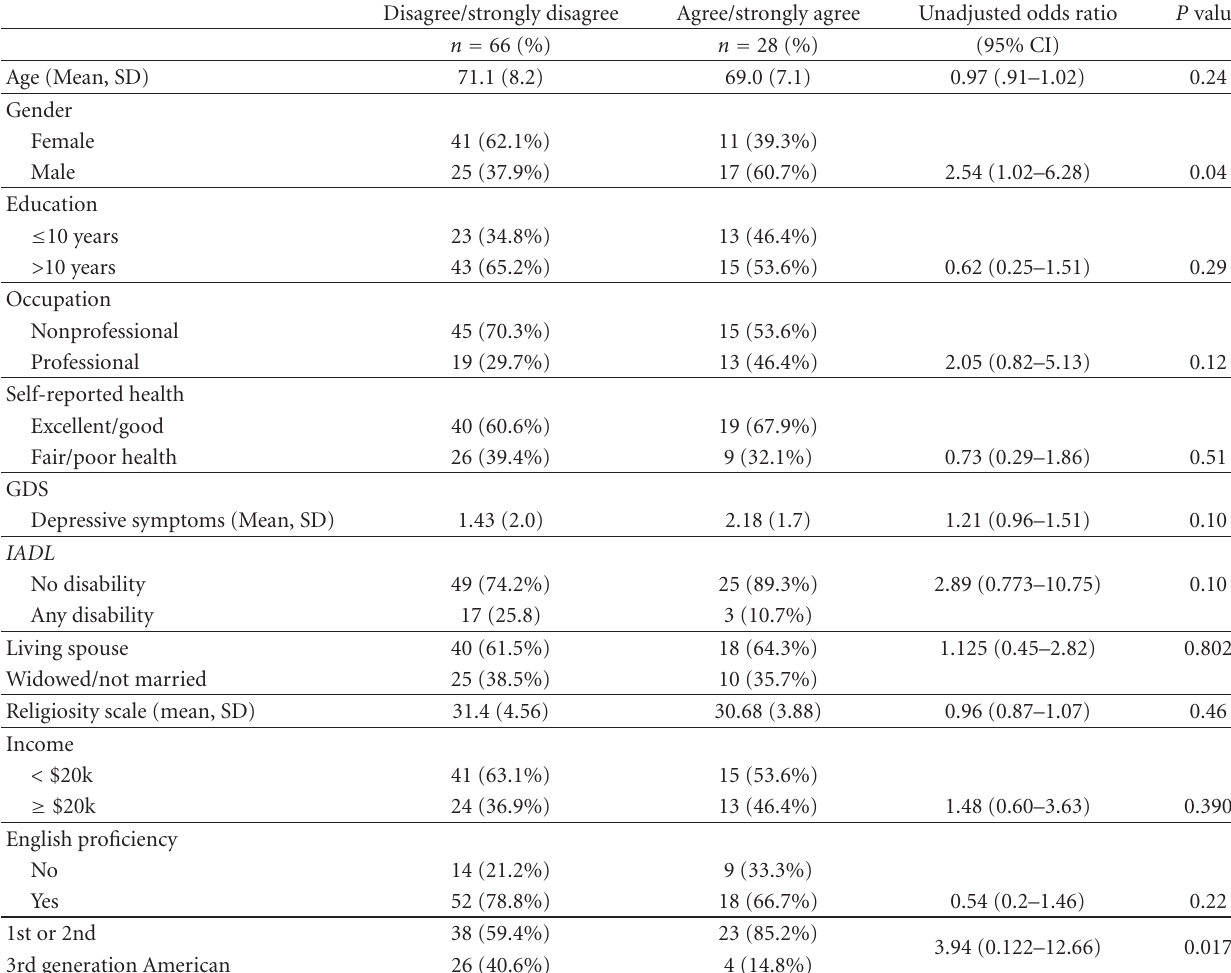
Table 2: Characteristics associated with agreement with ventilator use in a terminal